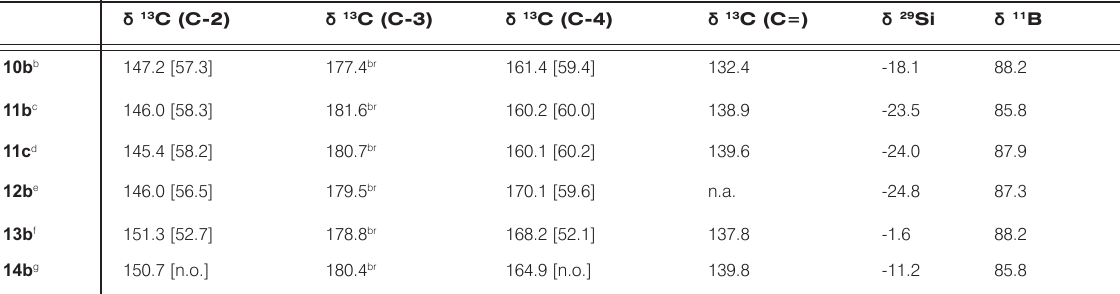
Table 2. 11 B, 13 C and 29 Si NMR data [a] for 1-silacyclobutene derivatives 10 - 14